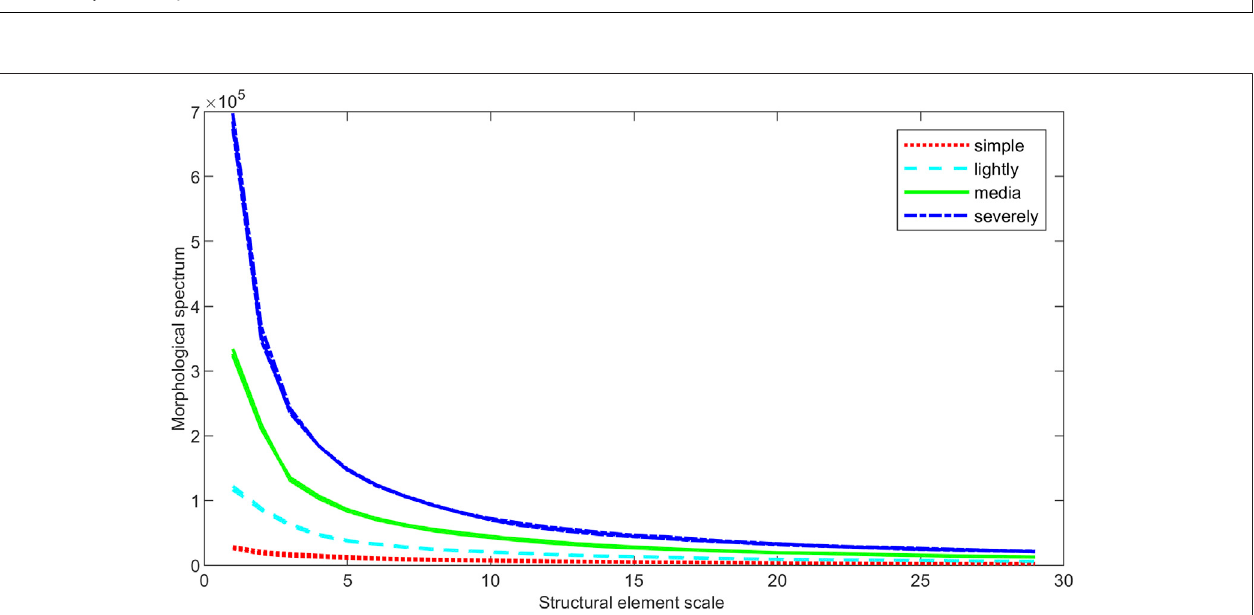
FIGURE 6 | MGS analysis result of square